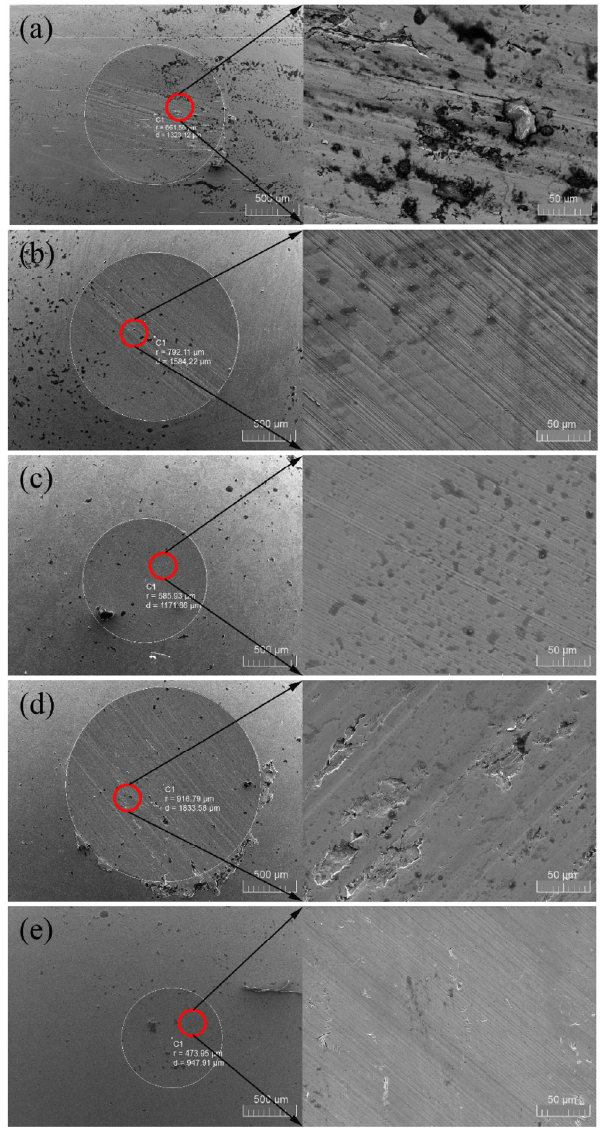
Fig. 11 SEM images of the steel ball after the tribological tests: (a) pure mineral oil and mineral oil containing 1.0 wt%, (b) pristine  -ZrP nanosheets, (c) HA_  -ZrP nanosheets, (d) DGA_  -ZrP nanosheets, and (e) OA_  -ZrP nanosheets. Left: low-magnification images (for WSD comparison), and right: high-magnification images (for surface topological